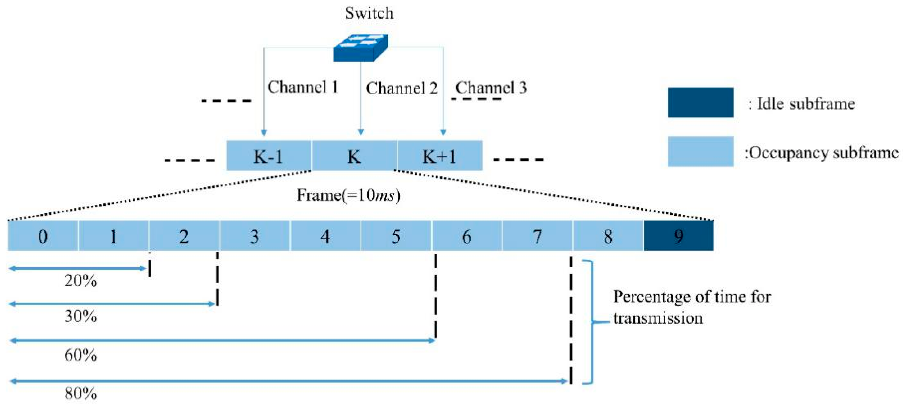
Figure 4. LTE-U DC and CA model.